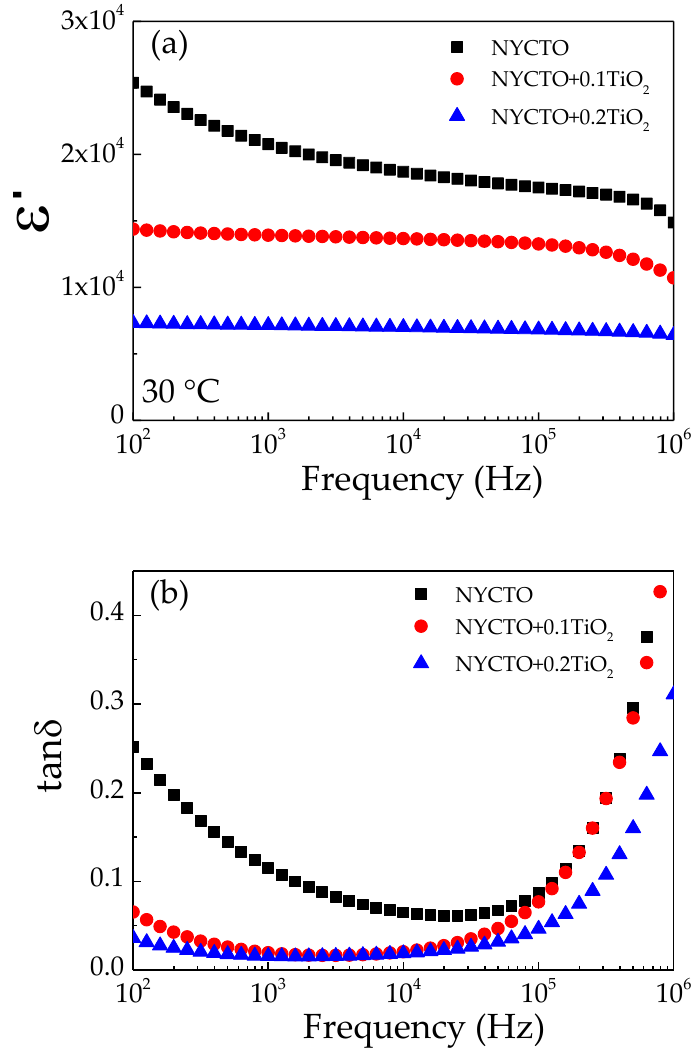
Figure 2. Dielectric properties at room temperature as a function of frequency for NYCTO + xTiO 2 ceramics with different doping content: ( a ) dielectric permittivity ( ε ′ ) and ( b ) loss tangent (tan δ ).